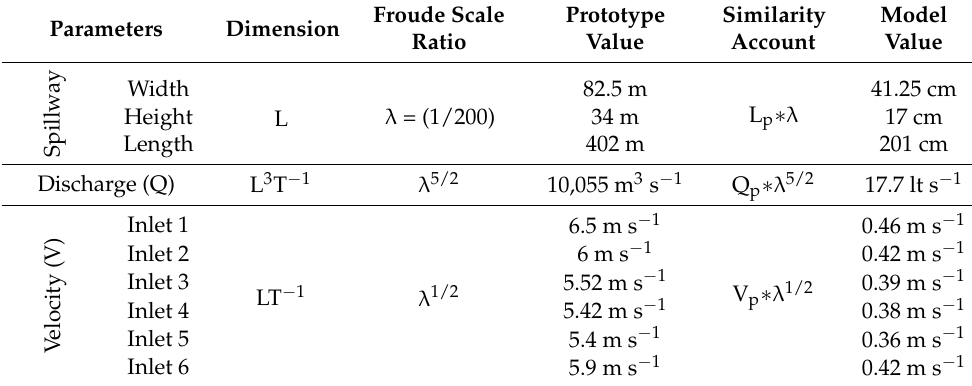
Table 2. Froude similarity values for prototype and model.